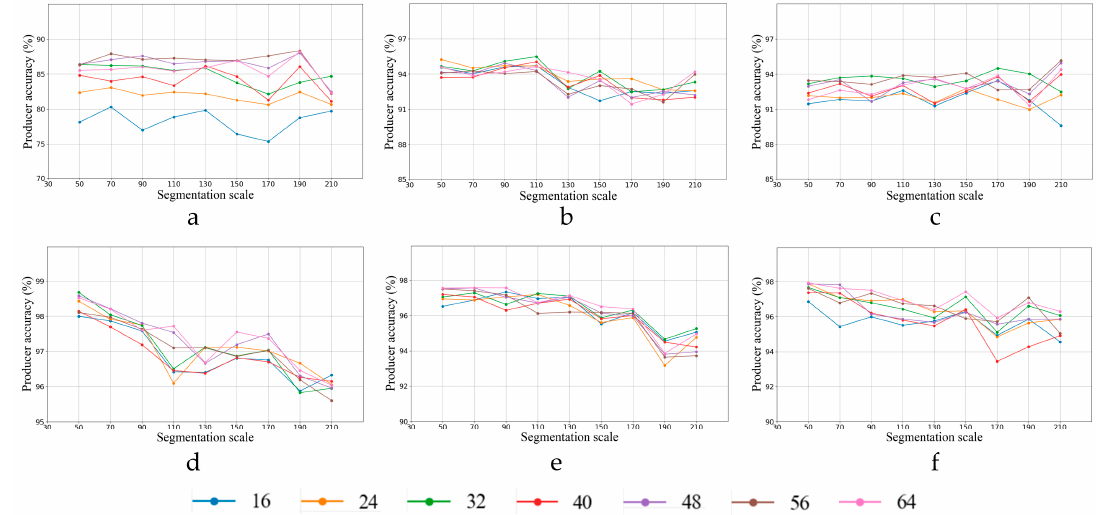
Figure 13. The variation of producer accuracies of Buildings ( a ), Vegetation ( b ), Roads ( c ), Water ( d ), Shadows ( e ) and Bare soils ( f ) over segmentation scales (the horizontal axis refers to segmentation scale, the vertical axis refers to accuracies, and different curves represent different patch sizes).